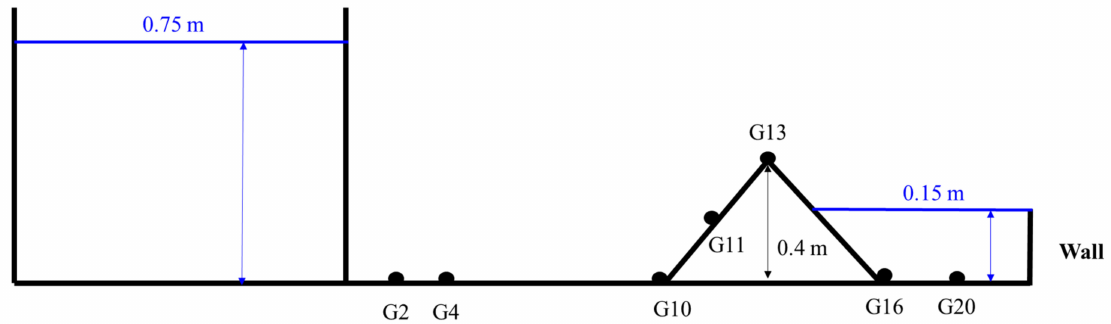
Figure 8. Flume test setup of the